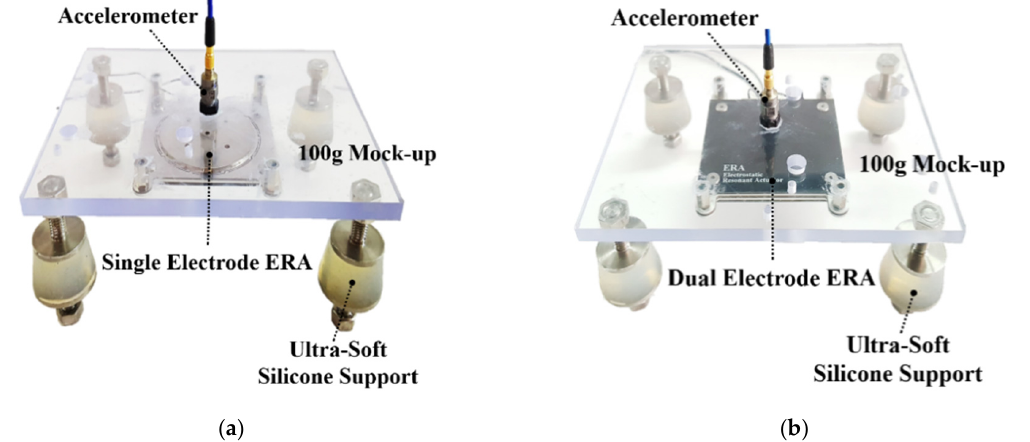
Figure 9. Experimental setup for measuring the output vibration intensities of the ERAs on mock-up panels: ( a ) test setup of the single-electrode ERA on a 100 g panel, ( b ) test setup of the dual-electrode ERA on a 100 g panel.